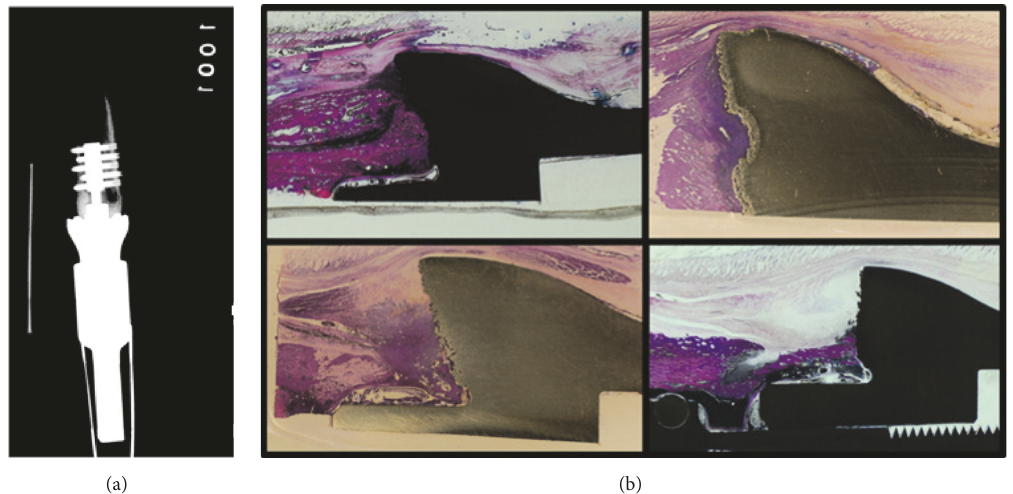
Figure 6: (a) This figure shows radiographs of the implant in Sheep 2A. (b) Histological analysis of Sheep 2A demonstrating osseointegration at all four quadrants.